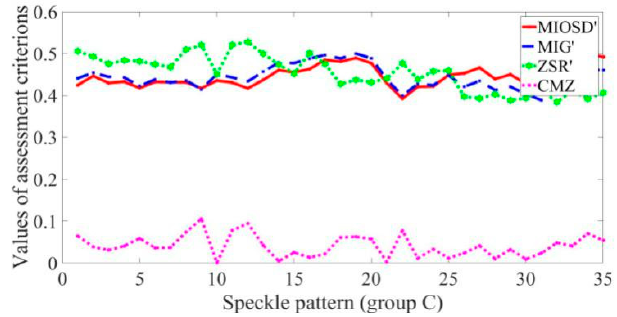
Figure 13. Comparison of different assessment criteria.